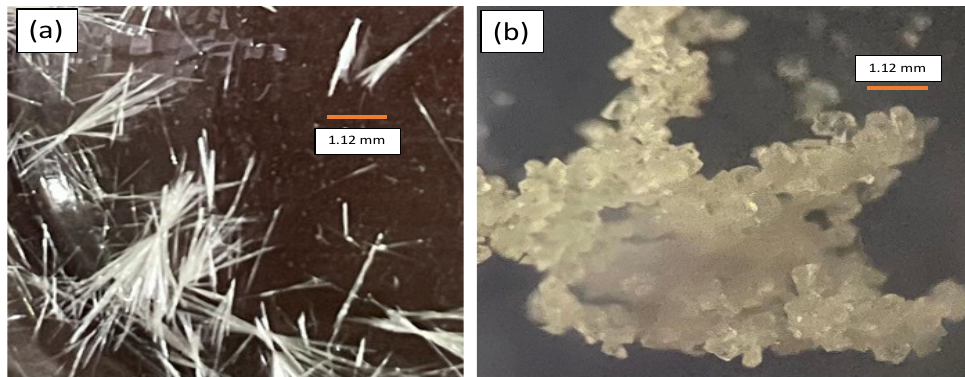
Figure 2. Single-crystal appearance of ( a ) LF-26 and ( b ) LF-35, both under 40x magnification. Note: LF-26 = levofloxacin 2,6 dihydroxybenzoic acid multicomponent system, LF-35 = levofloxacin 3,5 dihydroxybenzoic acid multicomponent system.